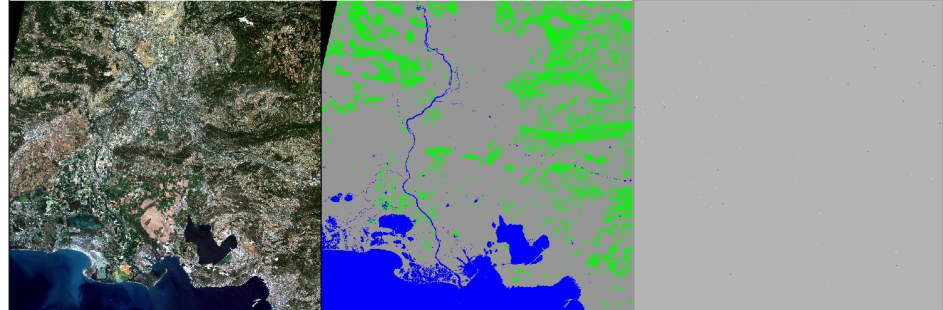
Figure 6. L1C RGB ( left ), DDV map Thuillier 2003 ( middle ) and DDV relative difference map between TSIS and Thuillier product ( right ), where the grey color represents a zero difference. The DDV classification masks are: DDV pixels (green), clear water (dark blue) and other (grey).